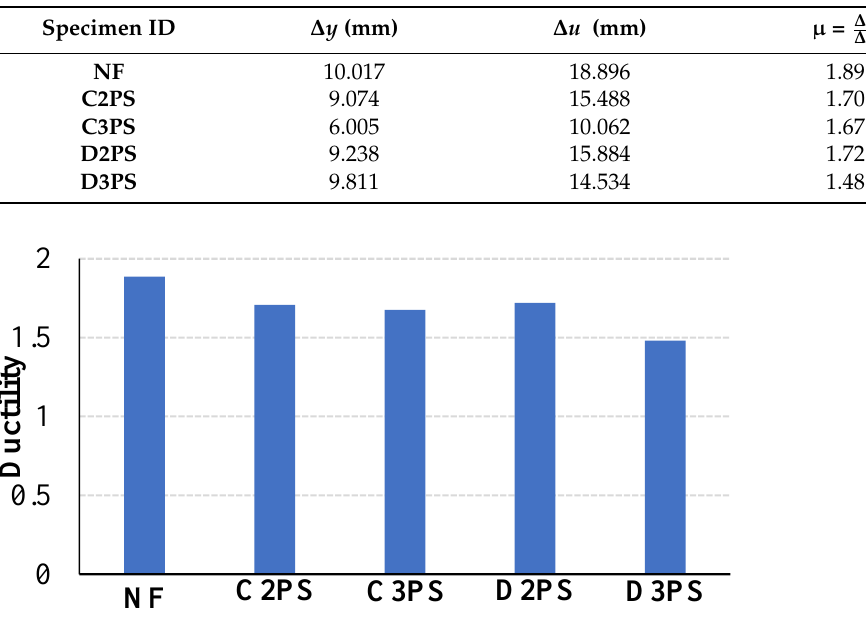
Figure 11. Average stiffness of tested specimens. Table 5. Stiffness for tested specimens.